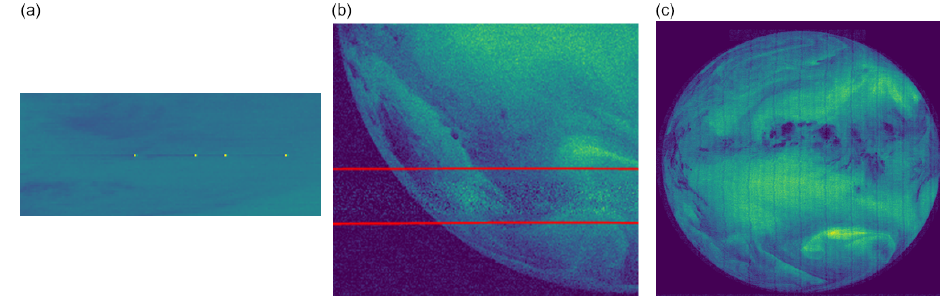
Figure 3. Examples of low-quality sensory data. (a) A scan line contains an interference pattern (file: METEOSAT4-MVIRI-MTP10-NA- NA-19911216110000, channel: WV). (b) A block of scan lines (inside the red lines) with a much lower signal-to-noise ratio than neighbour- ing scan lines (file: METEOSAT2-MVIRI-MTP10-NA-NA-19831016120000, channel: WV). (c) Image contains an unknown disturbance pattern (file: METEOSAT2-MVIRI-MTP10-NA-NA-19810817223000, channel: WV). The pixel values are the raw digital counts (see also Fig. 2; ©EUMETSAT).